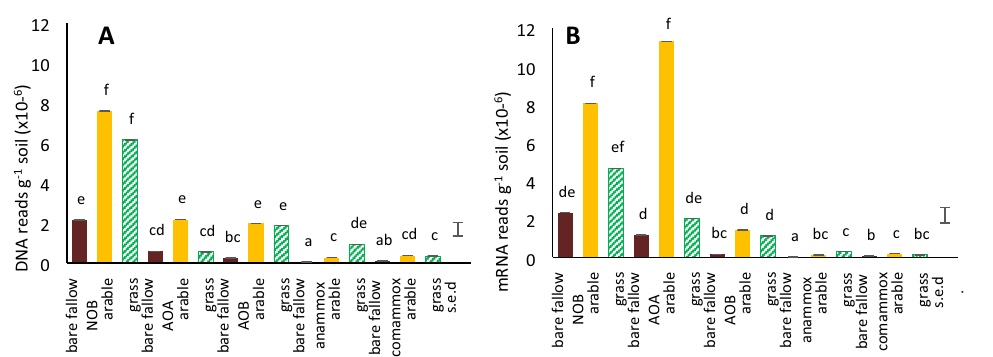
Figure 2. Mean relative abundance: ( A )—DNA and ( B )—mRNA reads g -1 dry soil assigned to nitrifying guilds in each soil treatment. Standard errors of differences of means (s.e.d.) shown for all groups; different letters indicate significantly different